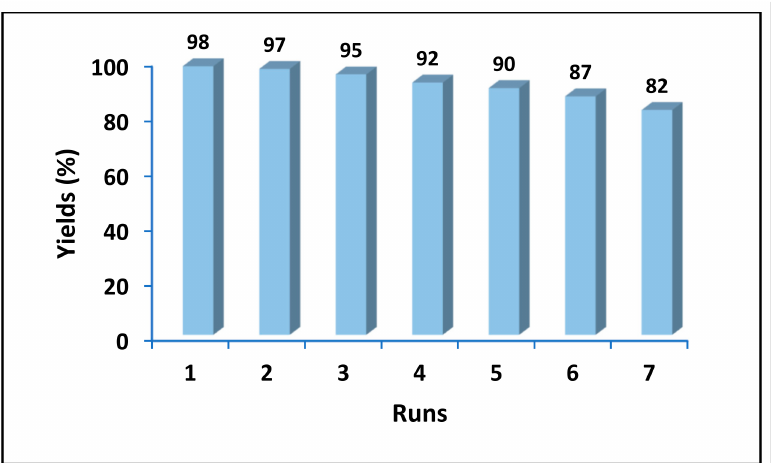
Figure 11. The yields of the model product for seven reaction runs by using the recovered Pd@Per-P under optimum reaction